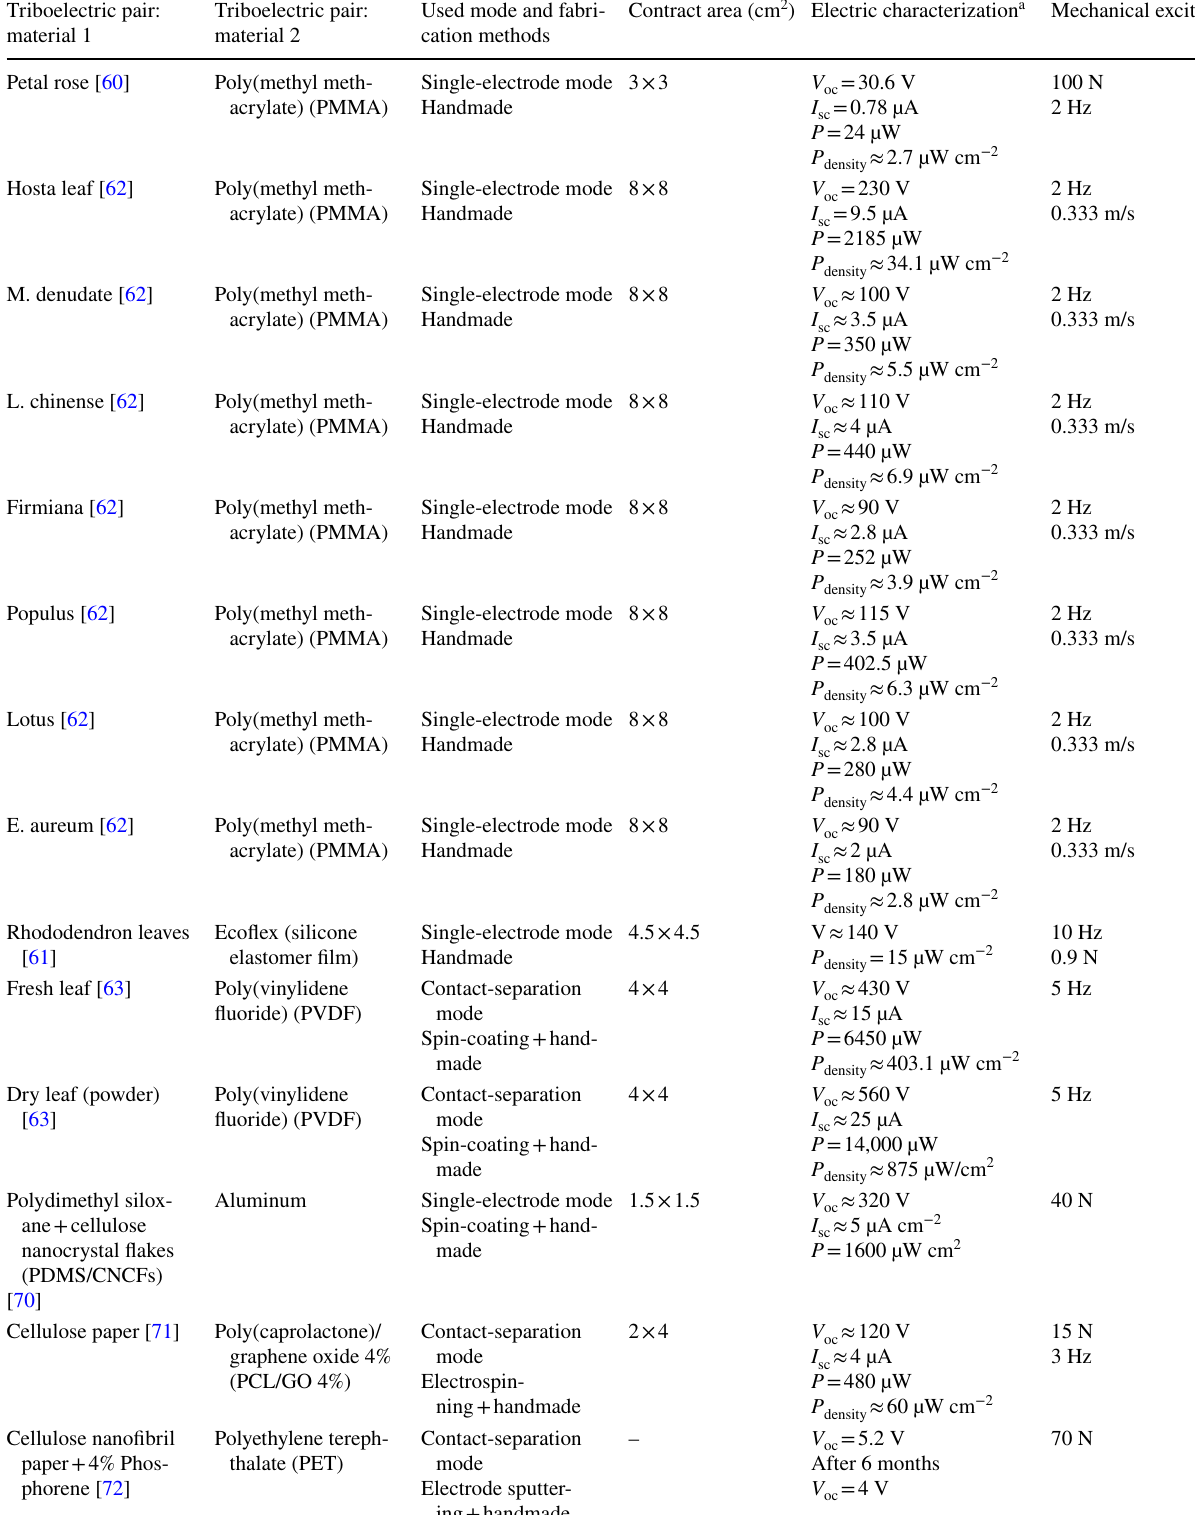
Table 1 Triboelectric pair materials and their triboelectric characteristics Triboelectric pair: material